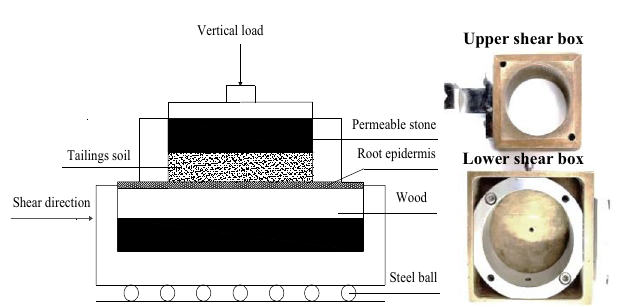
Figure 4. Schematic diagram of straight shear friction test.